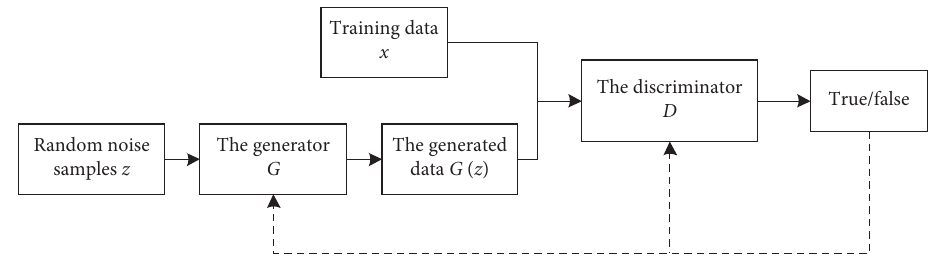
Figure 1: The basic framework of the original GANs. The GANs consist of two networks: a generative network (generator G ) and an adversarial network (discriminator D